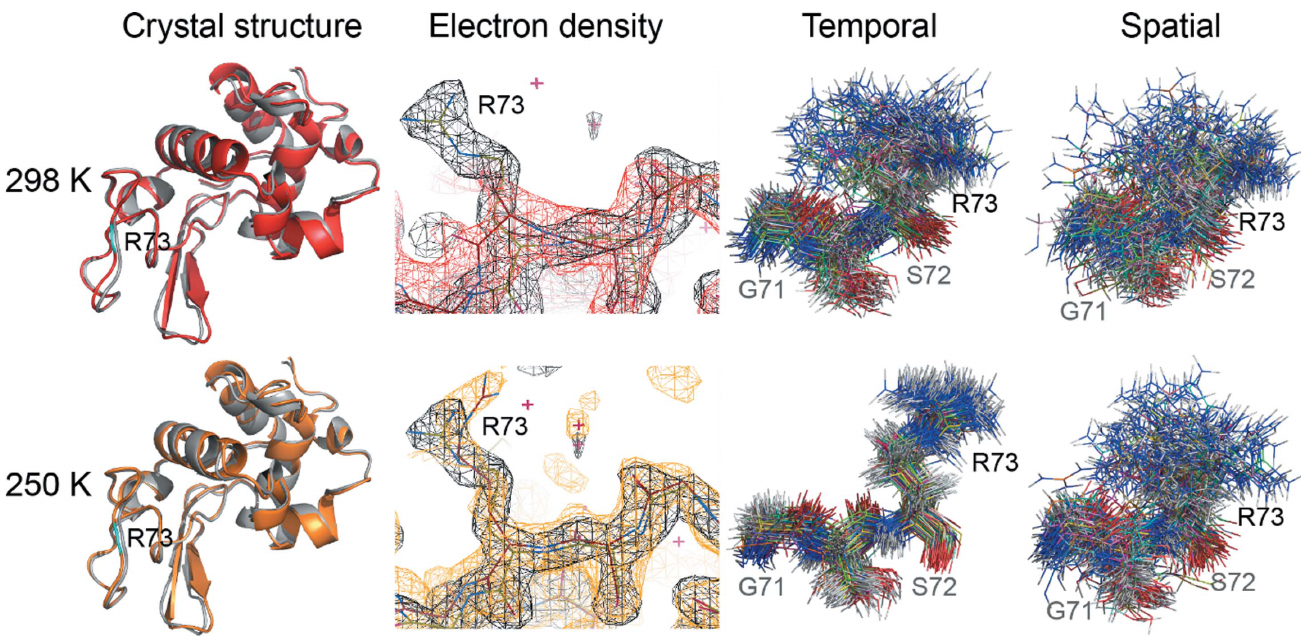
Figure 2 The side-chain dynamics of residue Arg73 in time representation and ensemble representation. First column: comparison of the experimental crystal structure (gray) and the recovered structures solved using the simulated diffraction data obtained from the MD trajectories at 298 K (red) and 250 K (orange). Residue 73 in the recovered structures is highlighted in cyan. Second column: electron density of residues 71–73 in the recovered structures (red for 298 K, orange for 250 K) and in our experimental structure (gray). Third column: the temporal ‘bundles’ containing 125 lysozyme molecules extracted from the uniformly spaced MD frames at 298 and 250 K (the frames sample the final two-thirds of the trajectory from 100 to 300 ns). Fourth column: the ensemble (spatial) ‘bundles’ containing 125 lysozyme molecules extracted from the last MD frame at 298 and 250 K. Note that for the trajectories that have not fully converged the thus-defined spatial bundles should be broader than the corresponding temporal